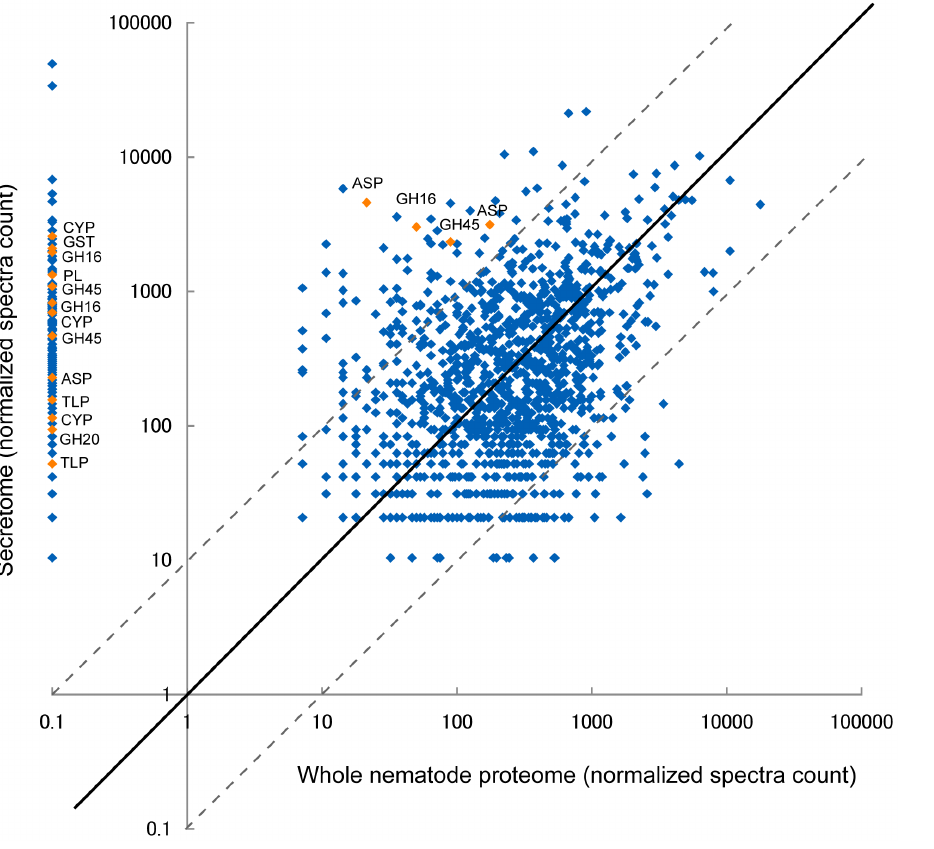
Figure 2. Relative abundance of secreted proteins compared to proteins from the whole Bursaphelenchusxylophilus lysate. The relative protein abundances were estimated from the MS/MS spectral counts. The number of spectral counts from each protein was normalized to the total MS/MS spectra number. Plots represent all secreted proteins identified in this secretome analysis. Orange plots represent typical proteins that could play an important role in B. xylophilus parasitism and are discussed in detail in this study. GH: Glycoside hydrolase; PL: Pectate lyase; GST: Glutathione-s-transferase; CYP: Cysteine peptidase, ASP: Aspartic peptidase, TLP: Thaumatin-like proteins.